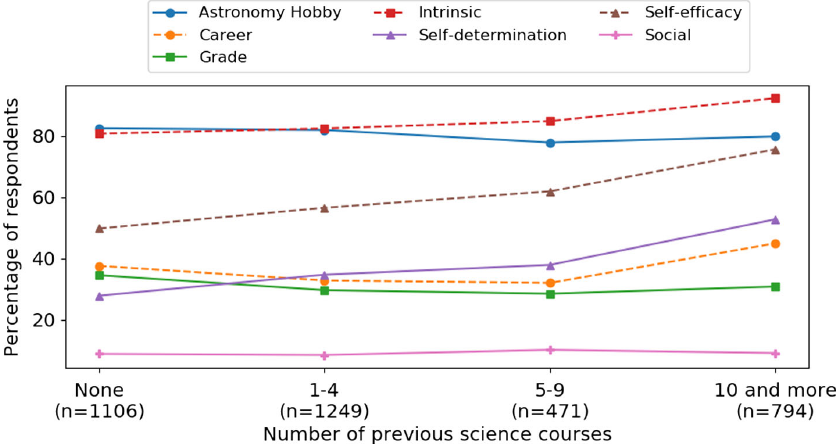
FIG. 5. Percentages of survey respondents in the high tier of each motivational category with number of previously taken science courses.